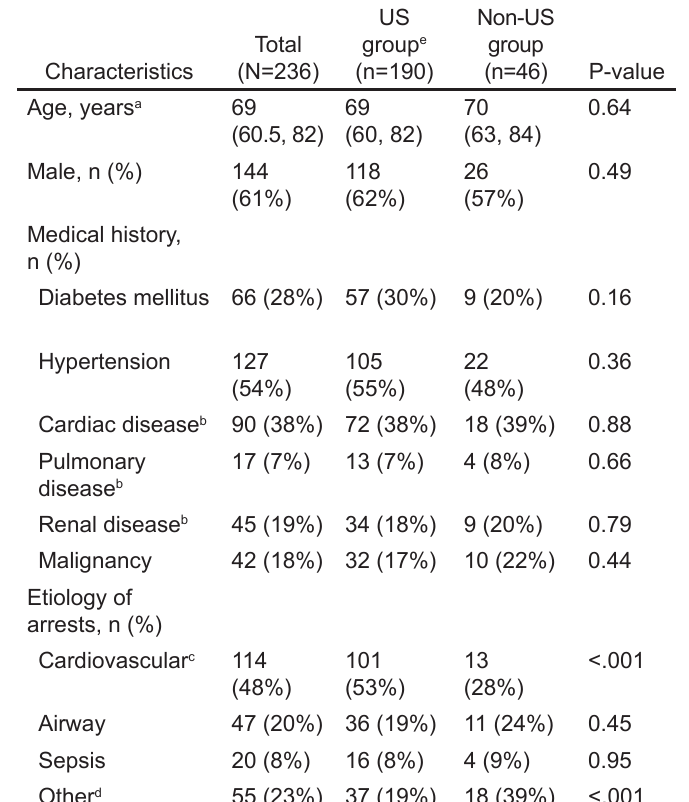
Table 1. Characteristics of the included